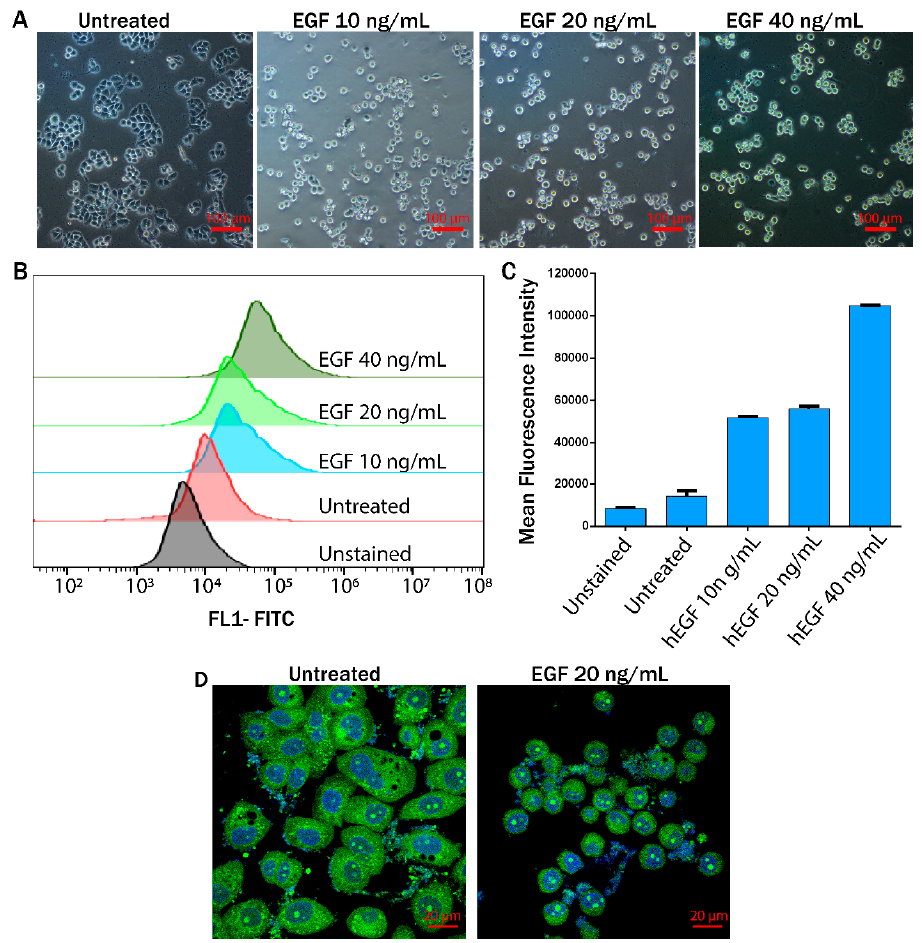
Figure 3. Epithelial to mesenchymal transition (EMT) induction in MDA-MB-468 cells. ( A )